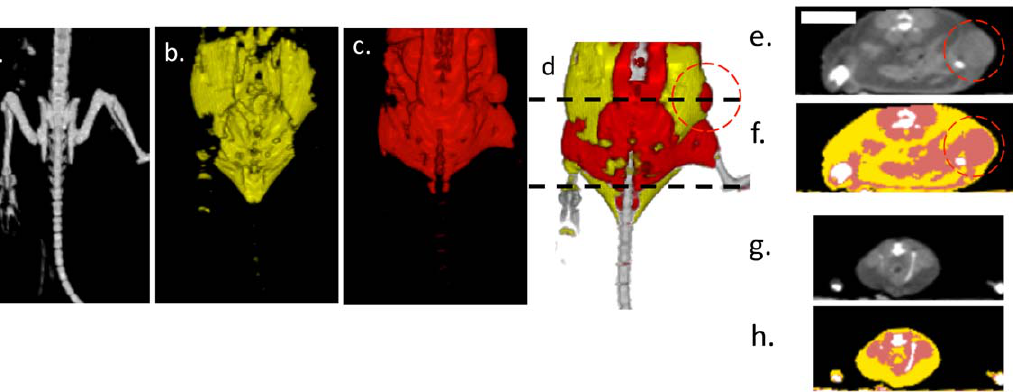
Figure 3. Hounsfield unit-based segmentation differentiates tissue types. (a–d) Isosurfaces of a mouse with a single hindlimb tumor, (a), bone, (b), fat, (c) soft tissue, (d), combined bone, fat and soft tissue isosurfaces. (e–h) Transverse plane CT images and segmented image from location of black dotted line in (d), where yellow indicates fat, red indicates soft tissue and white indicates bone.